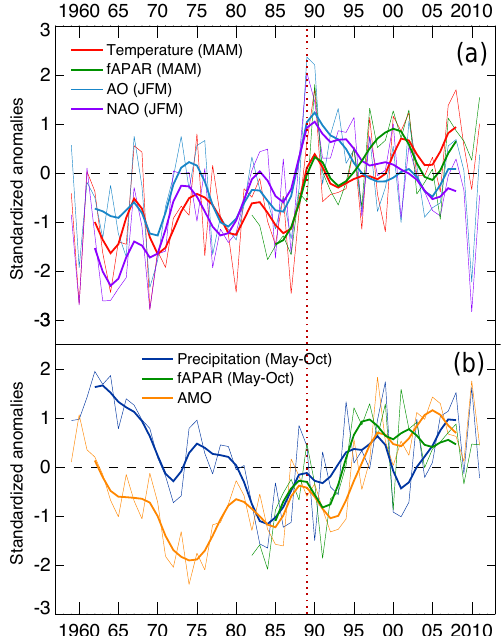
Figure 4. Synchronous continental shifts in climate and satel- lite vegetation data and links to North Atlantic climate variabil- ity. In panel (a) , temporal variations in spring (MAM) tempera- ture and satellite-based vegetation activity (fAPAR) representative of the northern Eurasian target region are plotted alongside the win- ter (JFM) Arctic Oscillation (AO) and North Atlantic Oscillation (NAO) time series. In panel (b) , temporal variations in wet-season (May–Oct) precipitation and fAPAR for the northern African tar- get region are plotted alongside the annual Atlantic Multidecadal Oscillation (AMO) time series. Plotted are both annual values (thin dotted lines) and a smoothed time series based on a seven-point binomial filter (thick lines). All time series are standardized anoma- lies relative to the satellite period 1982–2011. All climate indices’ time series are obtained from www.esrl.noaa.gov. Definitions of the AO and NAO are given in Thompson and Wallace (1998) and Hur- rell (1995), respectively. The AMO is a detrended area-weighted average of North Altantic SSTs (0–70 ◦ N) (Enfield et al.,